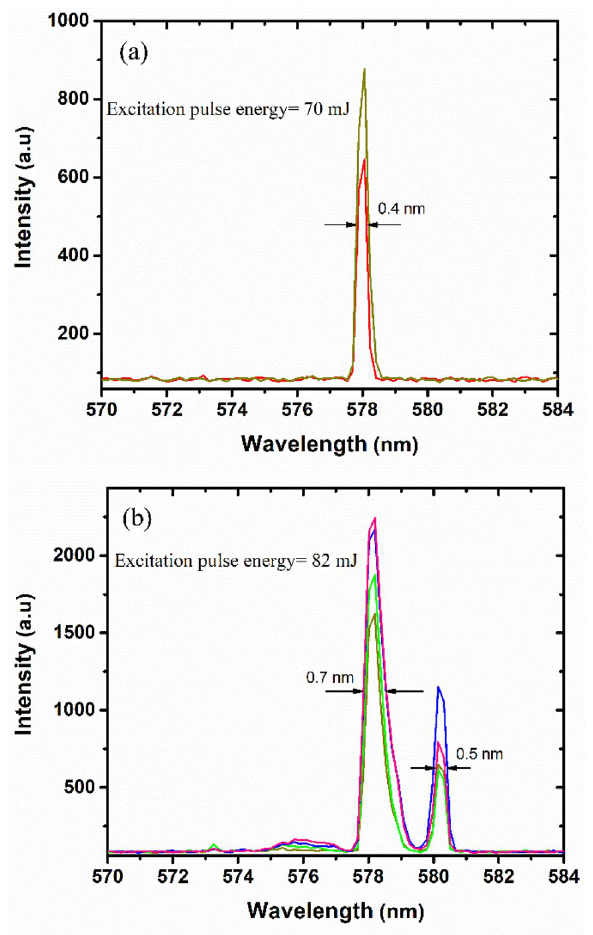
Figure 7. The behavior of Raman signals at independent single shots at ( a ) 70 mJ/pulse and ( b ) 82 mJ/pulse in Rhodamine 6G solution containing ZnO